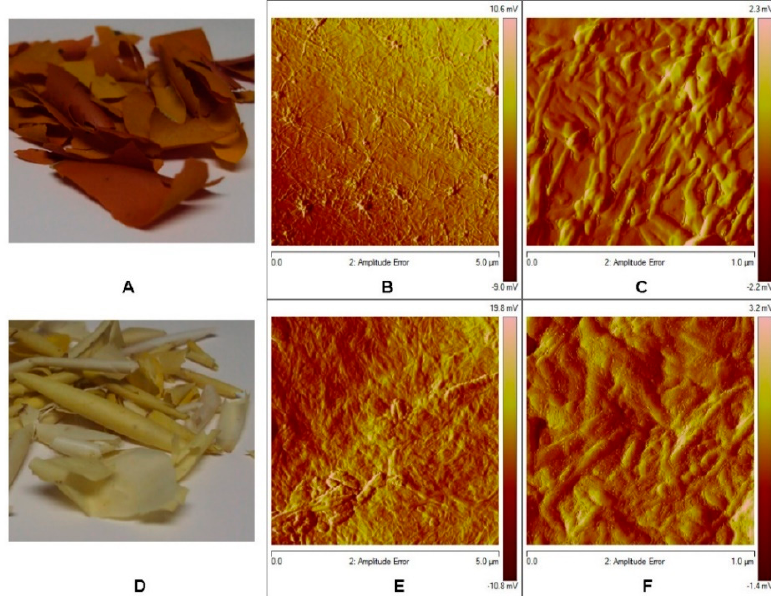
Figure 5. Atomic force microscopy tapping mode topographical images from ( A ) S. aculeatissimum ( B